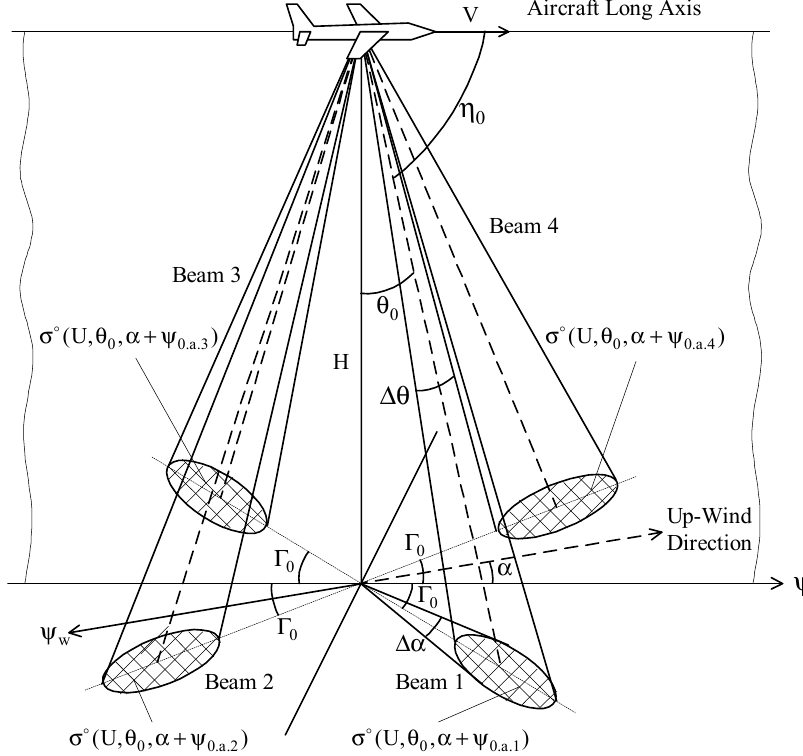
Figure 1. Spatial orientation of the Doppler navigation system (DNS) beams: λ -configuration (beams 1, 2, and 3) and x -configuration (beams 1, 2, 3, and 4). V is the speed of flight; H is the aircraft altitude; ψ is the aircraft course; ψ w is the sea surface wind direction; α is the angle between the up-wind direction and the aircraft course; θ 0 is the mounting angle of a beam axis in the vertical plane; Γ 0 is the mounting angle for a beam axis in the horizontal plane; η 0 is the mounting angle for a beam axis in the inclined plane; Δ α is the angular resolution in the azimuthal plane; Δ θ is the angular resolution in the vertical plane; σ ◦ ( U , θ 0 , α + ψ 0. a .1 ) , σ ◦ ( U , θ 0 , α + ψ 0. a .2 ) , σ ◦ ( U , θ 0 , α + ψ 0. a .3 ) , and σ ◦ ( U , θ 0 , α + ψ 0. a .4 ) are the normalized radar cross-section (NRCS) values obtained with beams 1, 2, 3, and 4, respectively; ψ 0. a .1 = Γ 0 , ψ 0. a .2 = 180 ◦ − Γ 0 , ψ 0. a .3 = 180 ◦ + Γ 0 , ψ 0. a .4 = 360 ◦ − Γ 0 .